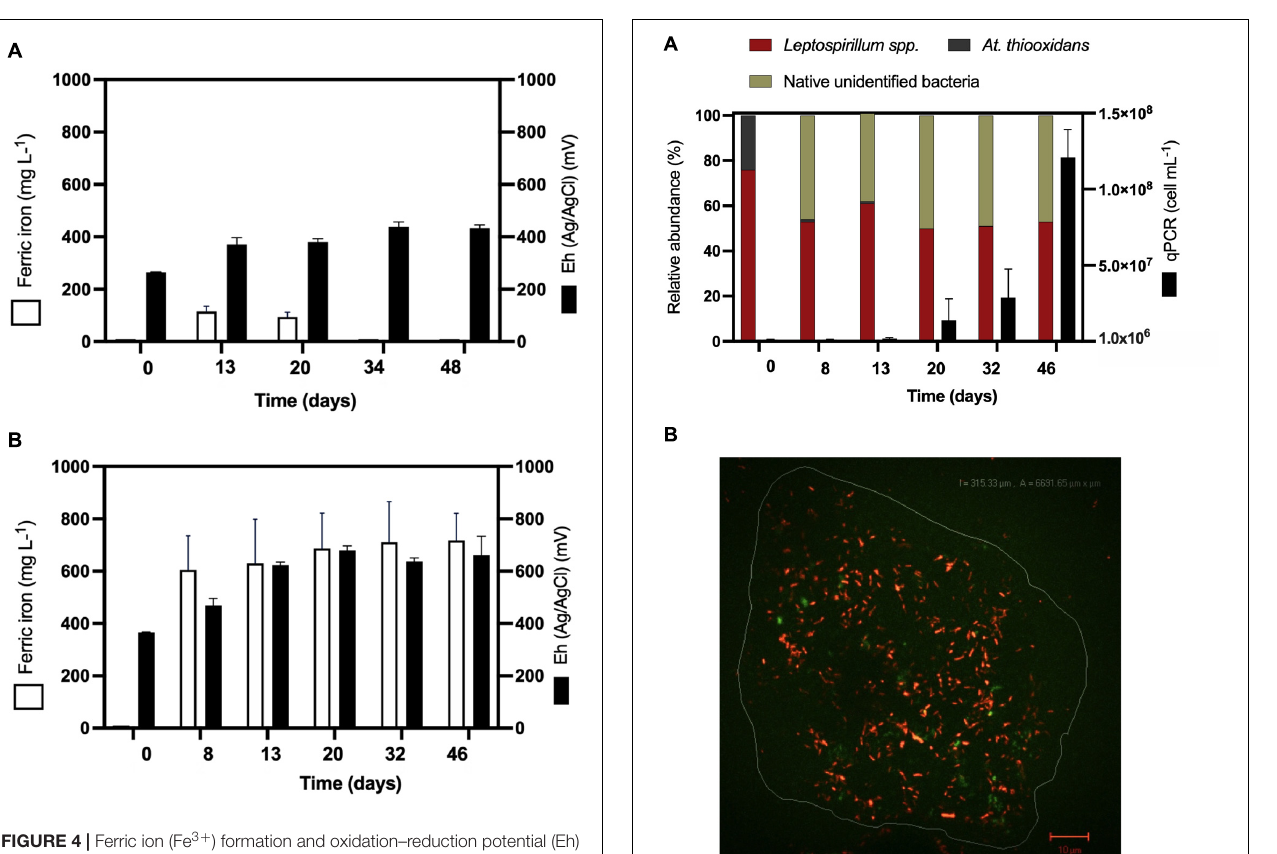
FIGURE 4 | Ferric ion (Fe 3 + ) formation and oxidation–reduction potential (Eh) during (A) turbulent flow bioleaching with addition of ferrous iron (700 mg/L) (screening method) and (B) laminar flow mesophilic bioleaching with addition of ferrous iron (700 mg/L) (flow cell method). FIGURE 5 | Microbiological determinations during high-purity natural bornite